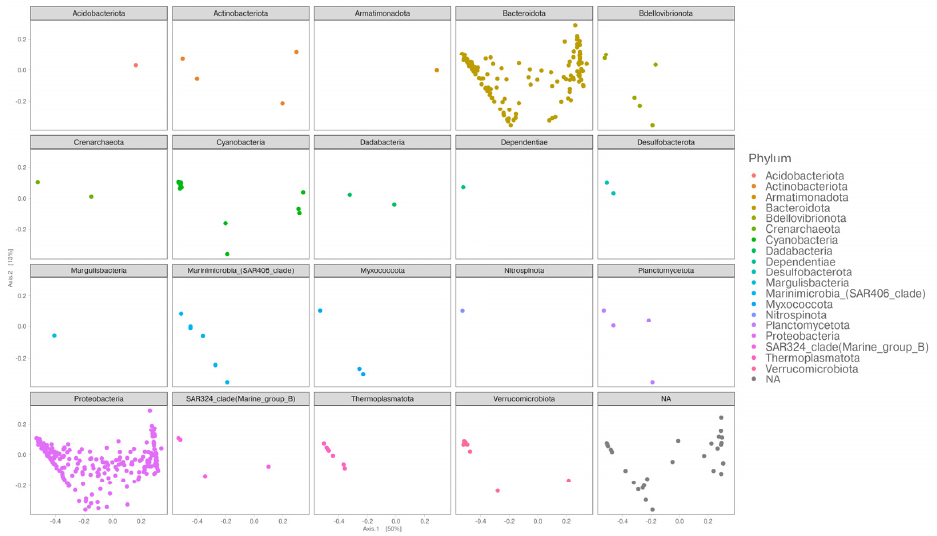
Figure 5. Principal Coordinate Analysis using a weighted Jaccard similarity distance illustrating the shifts in the community structure according to Southern Ocean waterfronts. SST—Sea Surface Temperature; POC:PN—Ratio between Particulate Organic Carbon and Particulate Nitrogen; STF— Sub-Tropical Front; SAF: Sub-Antarctic Front; PF—Polar Front; SACCF—Southern Antarctic Circumpolar Current Front; SBDY—Southern Boundary Front; RSCS—Ross Sea Continental Shelf. The amount of variance explained by each axis is reported within square brackets.